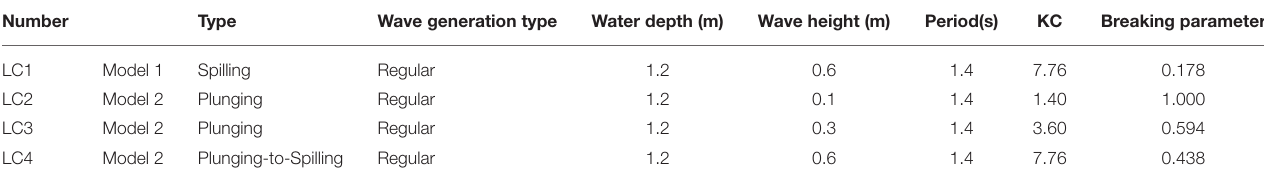
TABLE 1 | Load case for breaking